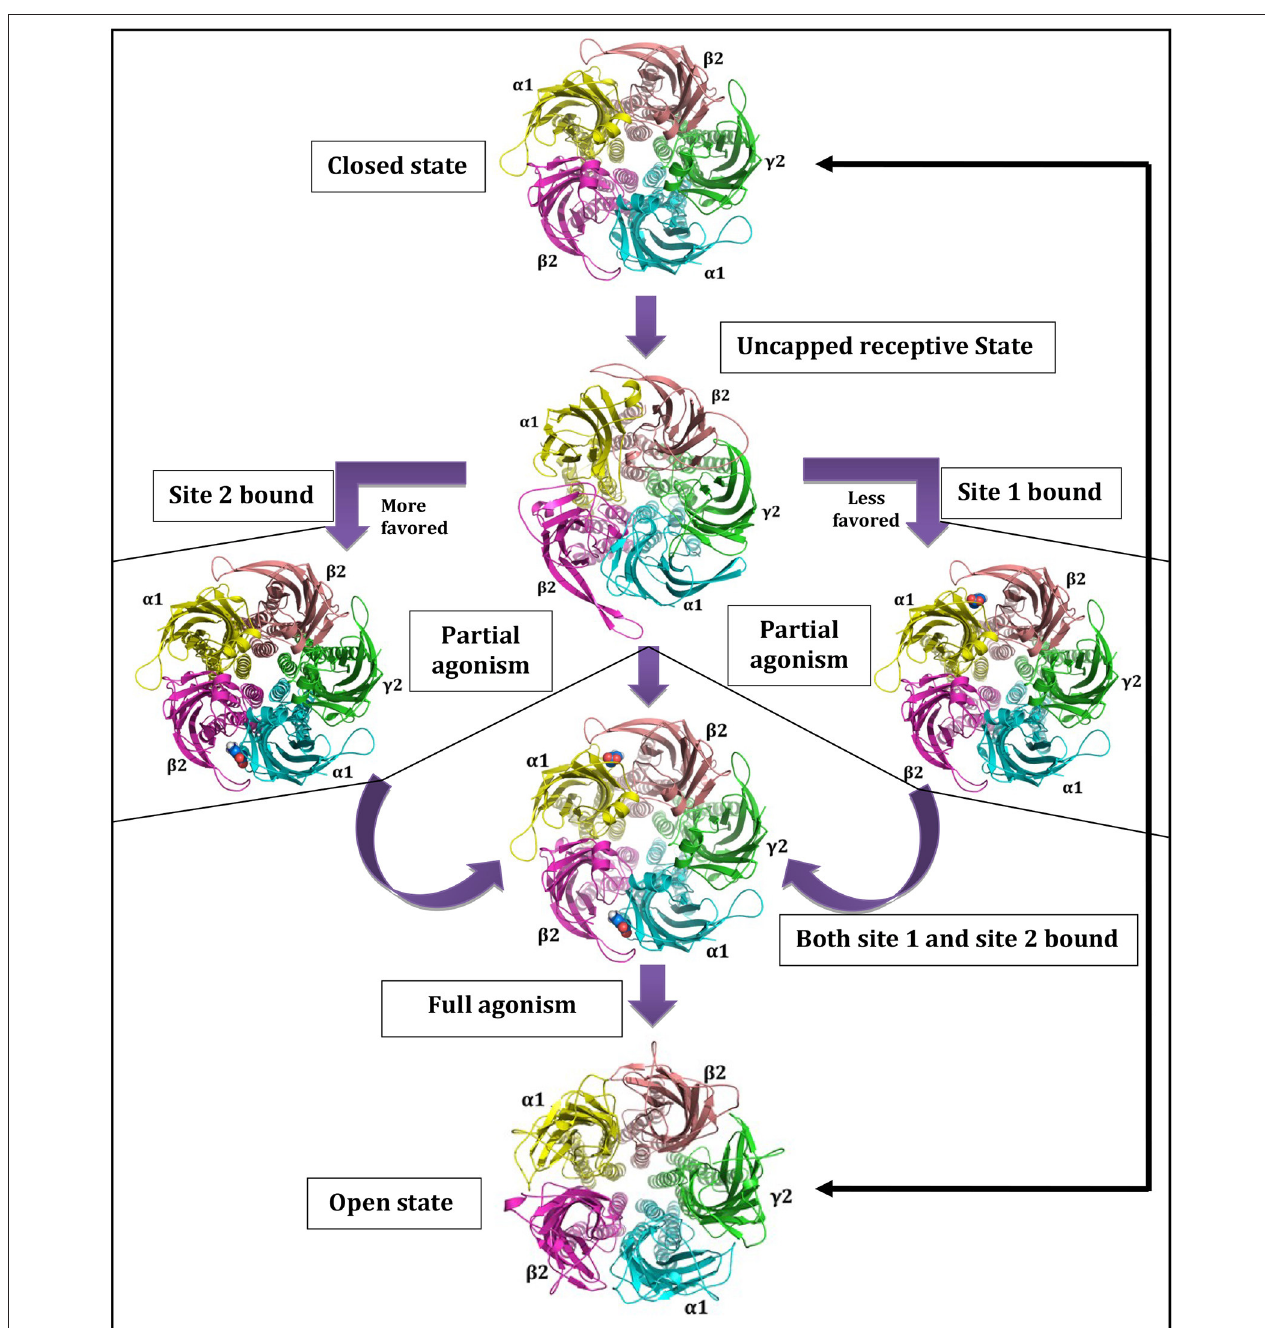
FIGURE 2 | Central role of uncapped receptive state in governing state as well as site dependant characteristics of GABA A -Rs. Reprinted by permission of Taylor & Francis Ltd, http://www.tandfonline.com [68].